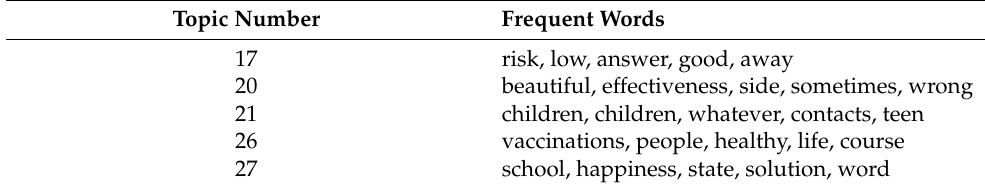
Table 2. Selected topics and their most frequent words.